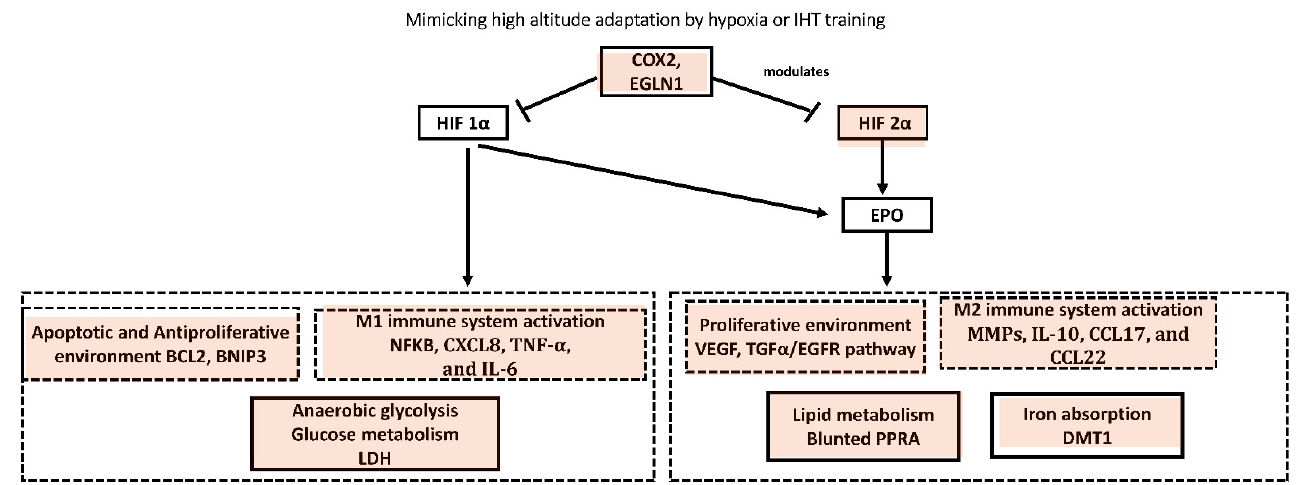
Figure 2. Schematic representation of HIF regulation of erythropoiesis. Gray boxes represent candidate genes that have been hypothesized to contribute to the blunted erythropoietic response and adapted among people living at higher altitude. OX2 is cyclooxygenase-2, PGE2 is prostaglandin E2, HIF-1 α is hypoxia-inducible factor 1-alpha, BCL2 is B-cell lymphoma 2, BNIP3 is BCL2/adenovirus E1B 19 kDa protein-interacting protein 3, NFKB is nuclear factor kappa B, EGLN1 is egl-9 family hypoxia-inducible factor 1, CXCL8 is C-X-C motif chemokine ligand 8, TNF- α is tumor necrosis factor-alpha, IL-6 is interleukin-6, LDH is lactate dehydrogenase, HIF-2 α is hypoxia-inducible factor-2 alpha, (VEGF is vascular endothelial growth factor, TGF α is transforming growth factor alpha, EGFR is epidermal growth factor receptor, MMPs is matrix metalloproteinases, CCL2 and 22 are chemokine (C-C motif) ligand 2 and 22, DMT1 is divalent metal transporter 1.